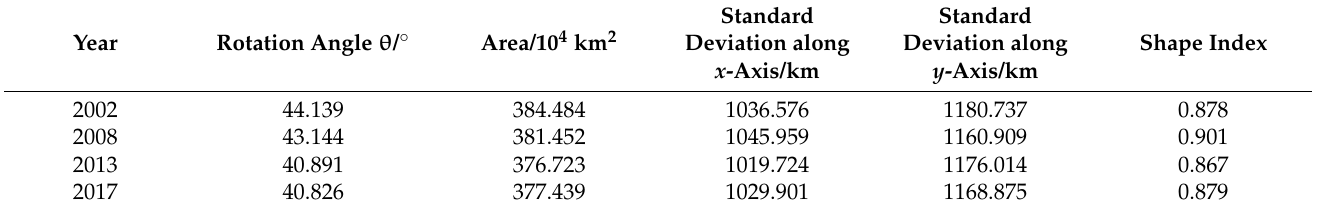
Figure 7. Inter-provincial GTFP standard deviational ellipse and center of gravity shift path in China. From the standard deviational ellipse parameters (Table 5), the range of variation of the long semi-axis of the ellipse from 2002 to 2017 was 1160.909 to 1180.737 km, while the range of variation of the short semi-axis was from 1019.724 to 1045.959 km. The standard deviational ellipse rotation angle was from 40.826 ◦ to 44.139 ◦ . The trend of the standard deviational ellipse range gradually decreased at each characteristic time point, indicating that the spatial distribution pattern of inter-provincial GTFP in China tended to be more and more concentrated. The shape index of the standard deviational ellipse was consistent with the change in the area of the standard deviational ellipse. The shape index kept decreasing, except in 2008, when it increased and displayed a trend of deviation from the positive circle, indicating that China’s inter-provincial GTFP was out of balance in east–west and north–south directions. Specifically, in the early period of the study (2002–2008), the long semi-axis shortened from 1180.737 km in 2002 to 1160.909 km in 2008, while the short semi-axis length extended from 1036.576 km in 2002 to 1045.959 km in 2008. In addition, the elliptical rotation angle kept decreasing, and the shape index of standard deviational ellipse had an expanding trend, increasingly changing to positive circles. In the middle and later stages of the study (2008–2017), the length of the long semi-axis first increased and then decreased. The length of the short semi-axis first decreased and then gradually increased. The elliptical rotation angle fluctuated less with a gradual reduction trend, revealing that the spatial distribution pattern of inter-provincial GTFP in China was relatively stable. Table 5. Standard deviational ellipse parameters for the spatial distribution pattern of inter-provincial GTFP in